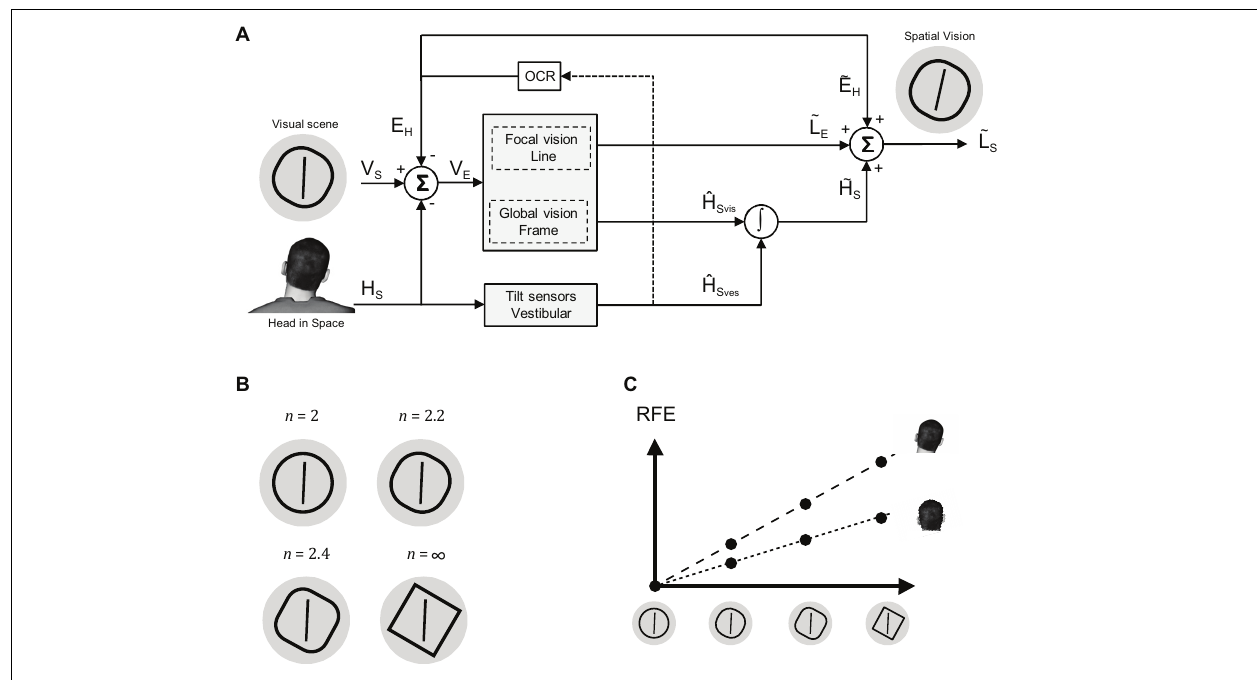
FIGURE 1 | (A) A schematic of the Bayesian model. (B) The four frame forms used: circle ( n = 2), squircle 2 ( n = 2.2), squircle 1 ( n = 2.4), and square ( n = ∞ ). (C) Hypothesized relation between frame form, head orientation, and magnitude of the rod-and-frame effect.